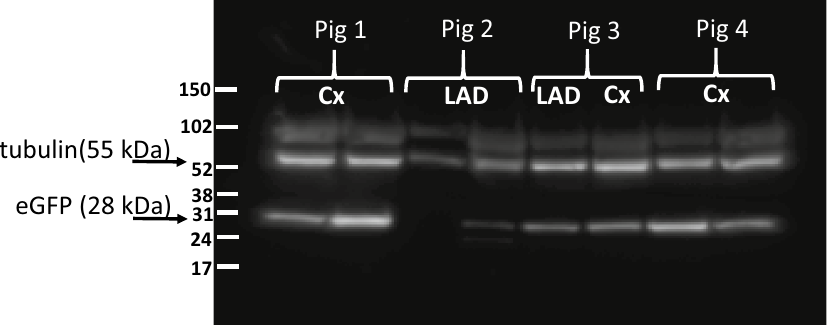
Figure 5. eGFP expression in non-diseased pig arteries treated with AAV2-eGFP stents. Western blot of protein extracts from coronary arteries receiving AAV2-eGFP stents (4 animals, 8 stents). The animals were euthanized 7 days after stent deployment. The extracted proteins from the stented segments were resolved by PAGE, transferred to a nitrocellulose membrane, and probed with anti-eGFP and anti-β-tubulin (loading control)